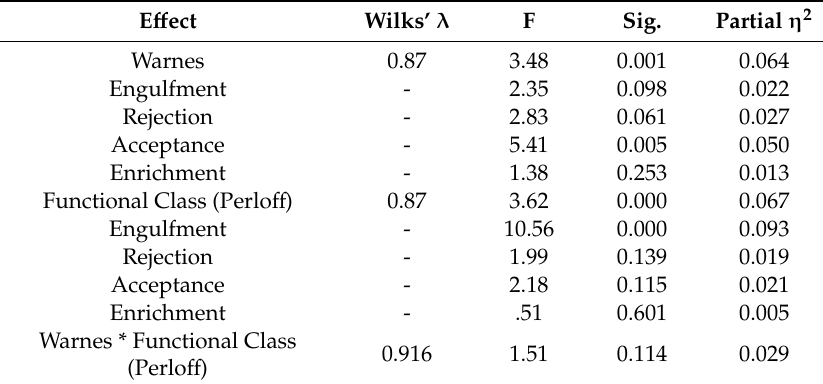
Table 4. Results of Multivariate and Between-subject Testing.